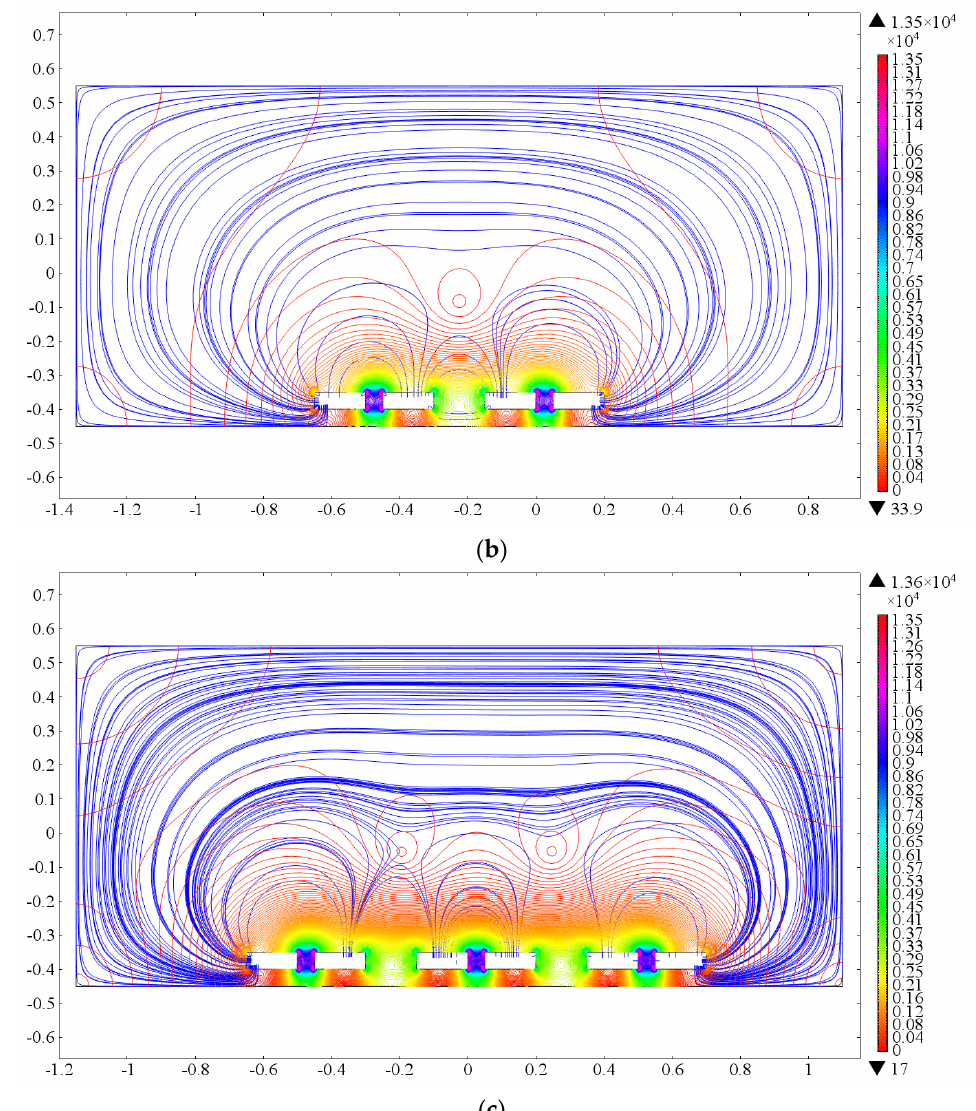
Figure 15. Schematic view of interaction between different number of PCSUs: a unit ( a ); two units ( b ); three units ( c ).